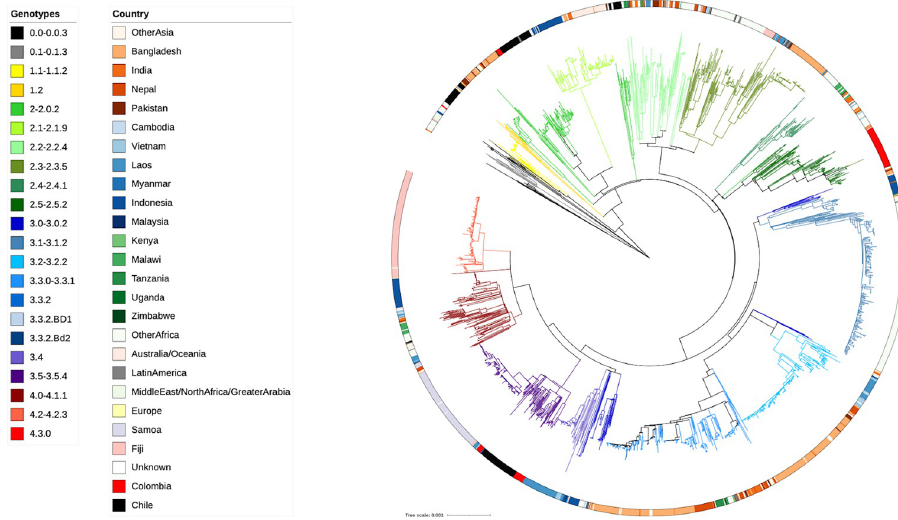
Fig 2. A global context maximum likelihood core genome phylogeny incorporating publicly available non-H58 and Santiago S . Typhi isolates. SNP based core genome maximum likelihood tree of 2013 global isolates, branches are coloured by genotype as per the inset legend; the ring indicates country of isolation as per the inset legend; Santiago isolates are highlighted in black and the Colombian isolates in red.